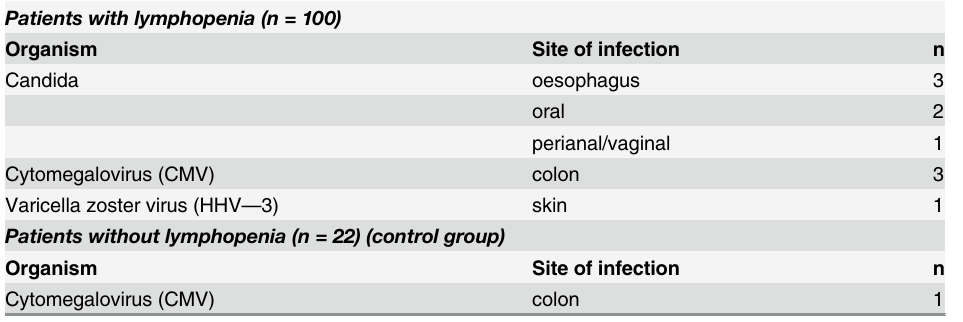
Table 4. Site of opportunistic infection.